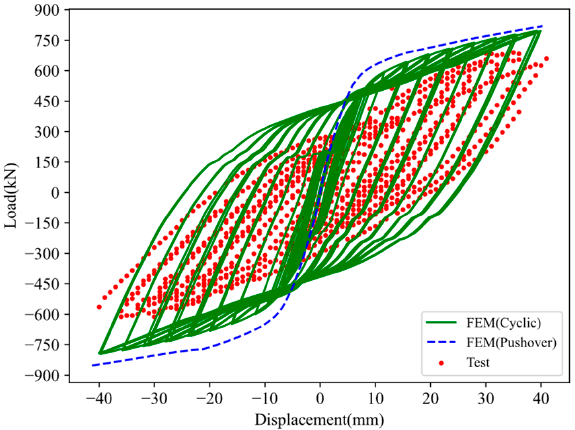
Figure 6. Hysteretic curves of FEM model and test model. Table 4. Some data from cyclic loading of FEM model and literature test.